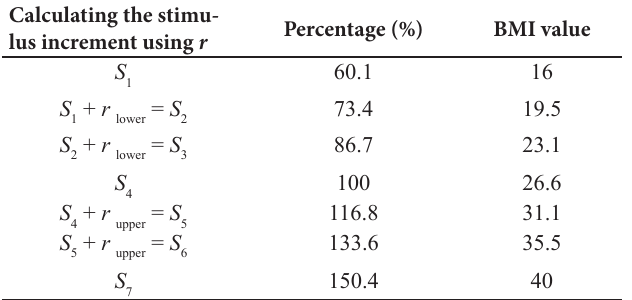
Table 3. Outcome of the calculation of the two sub-scales of a geo- metric progression of a limited scale of image sizes for a participant with a BMI of 26.6.